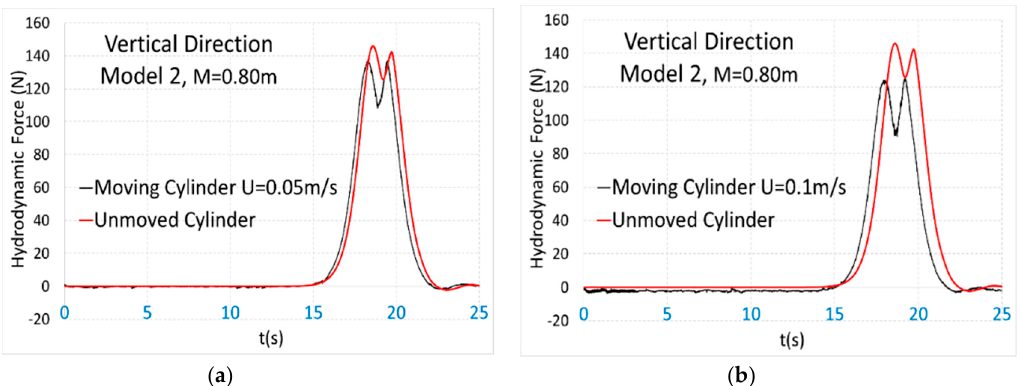
Figure 20. The time variation of hydrodynamic forces for model 2. ( a ) The comparison between the unmoved cylinder (red line) and the moving cylinder at U c = 0.05 m/s. ( b ) The comparison between the unmoved cylinder (red line) and the moving cylinder at U c = 0.1 m/s.